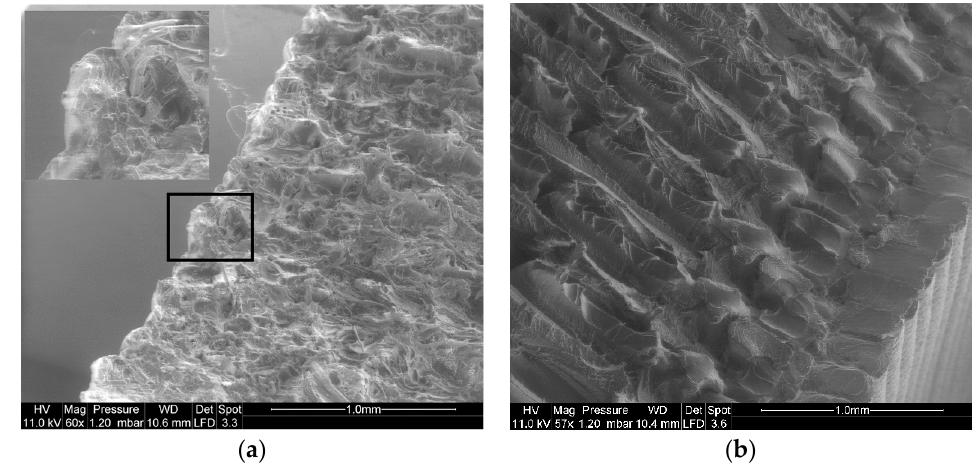
Figure 11. SEM micrographs showing the morphology of 3D printed PLA and PF at 200 °C. ( a ) PF, ( b ) PLA.